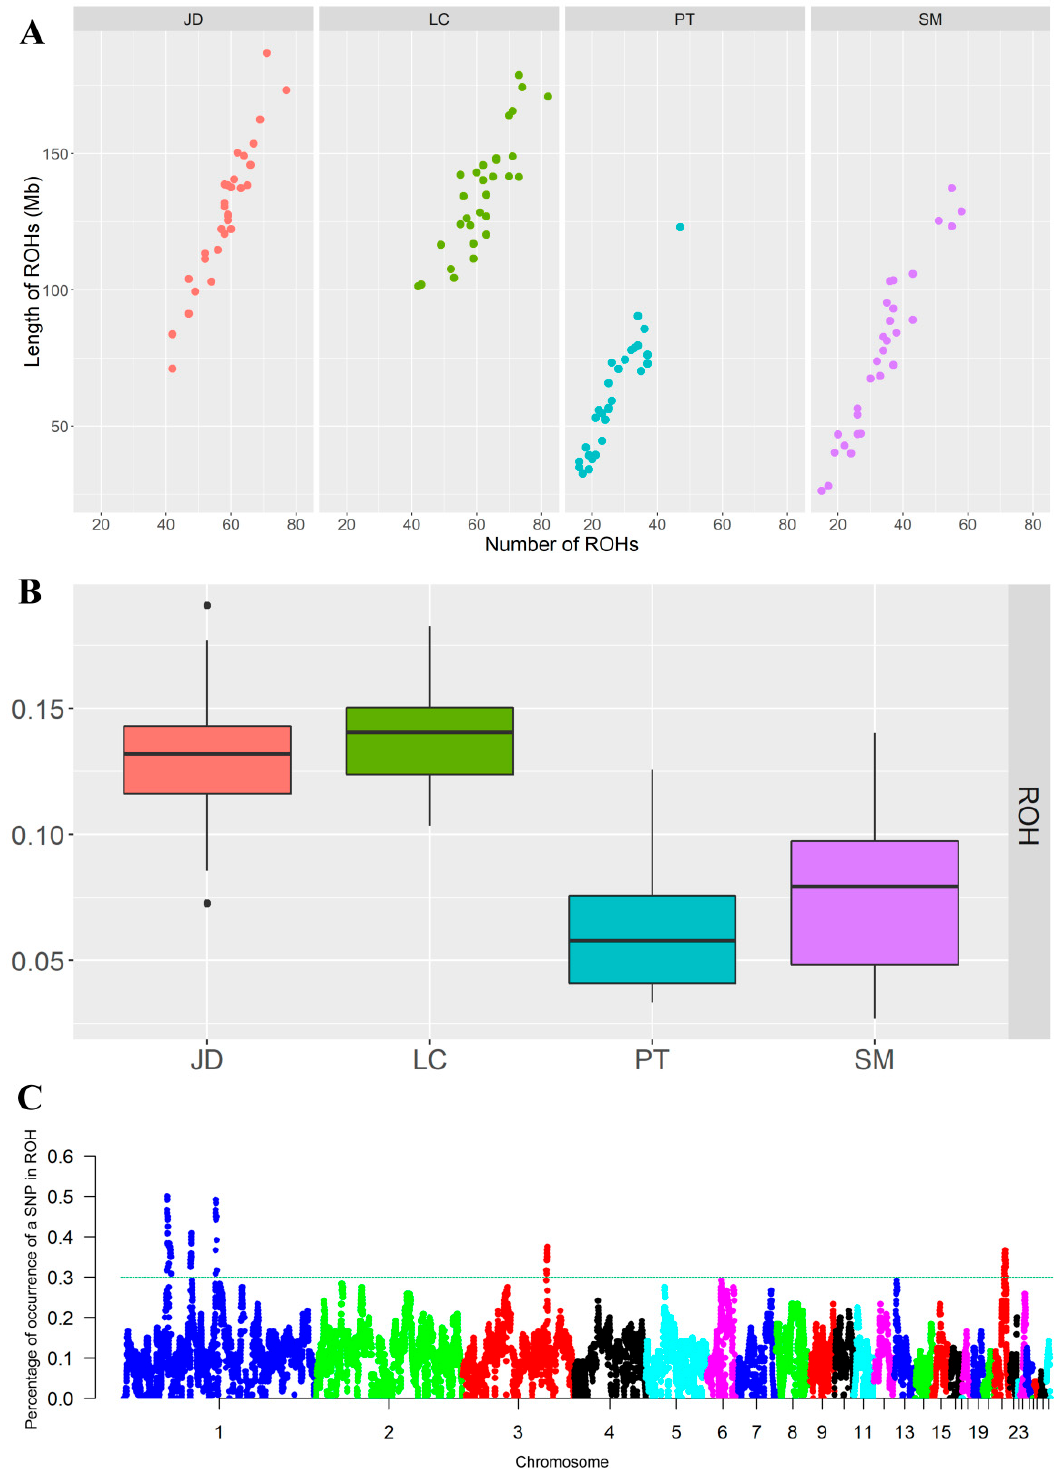
Figure 5. Genome-wide scan for ROH. ( A ): Number of ROH per breed (X-axis) and the total ROH length of each animal (Y-axis). ( B ): Box plot of the inbreeding coefficients inferred from ROH (F ROH ) for duck breeds. ( C ): Manhattan plot of the incidence of each SNP in the runs of homozygosity among the duck breeds.